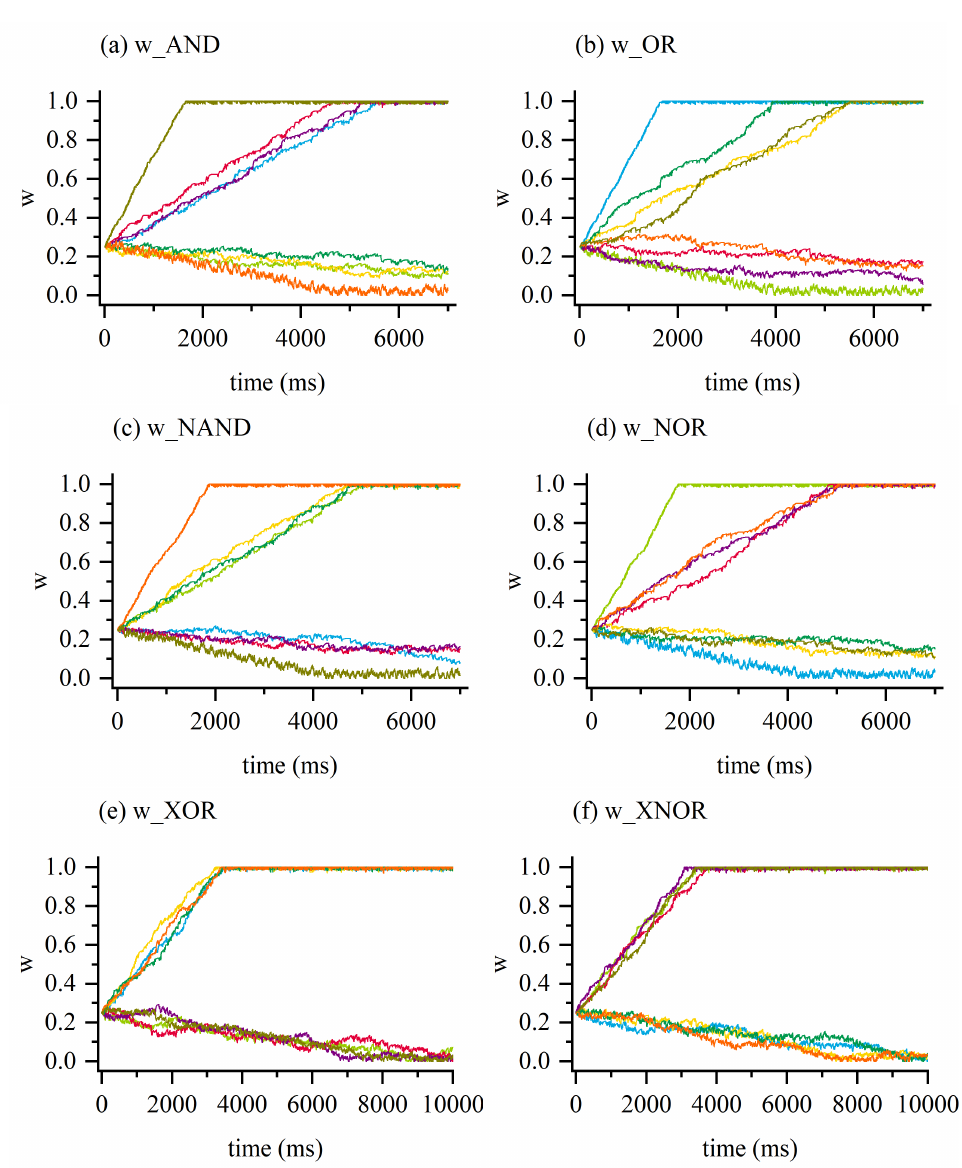
Figure 5. The changes in synaptic weights between the pattern layer and the output layer. Lines with different colors in the same sub-figure indicate the weight of different synapses in the same module; lines with the same color in different sub-figures indicate the weight of the same synapse in different